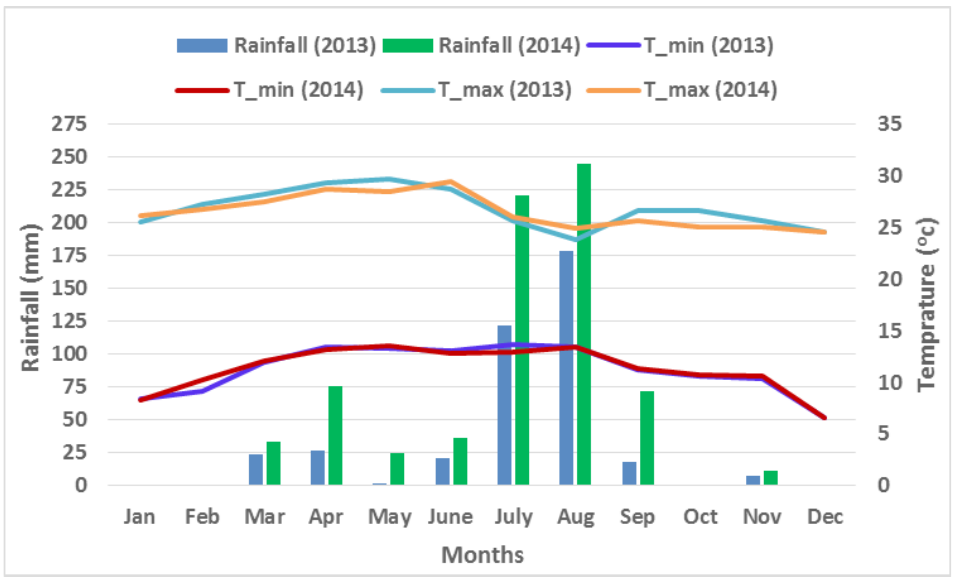
Figure 1: Monthly total rainfall (mm) and monthly average air temperature ranges (T 0 ), in 2013 and 2014 cropping season .Source: Mekelle Research Meteorological